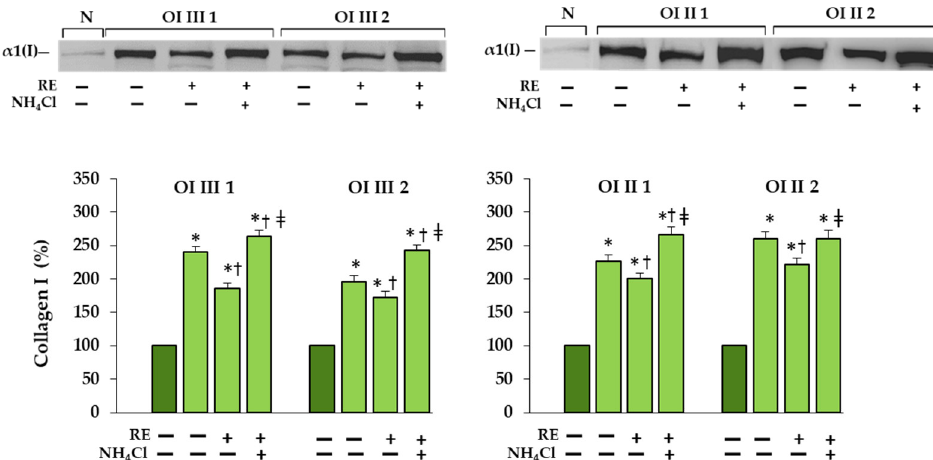
Figure 5. Western blot analysis of type I collagen in the lysosome-enriched cellular fraction, prepared as described in Methods, in OI types III and II cells treated with 50 µ g/mL RE and 50 mM NH 4 Cl. Equal amounts of proteins were loaded on 10% polyacrylamide gel. The bars represent the results of the gel densitometry as the mean values from three independent experiments; * p < 0.05, OI cells vs. normal (N) cells; † p < 0.05, OI cells treated with RE vs. OI untreated cells; ‡ p < 0.05, OI cells treated with RE + NH 4 Cl vs. OI cells treated with RE alone. The data are expressed as a percentage of the normal sample taken as 100%; dark green and light green bars represent normal and OI, respectively.